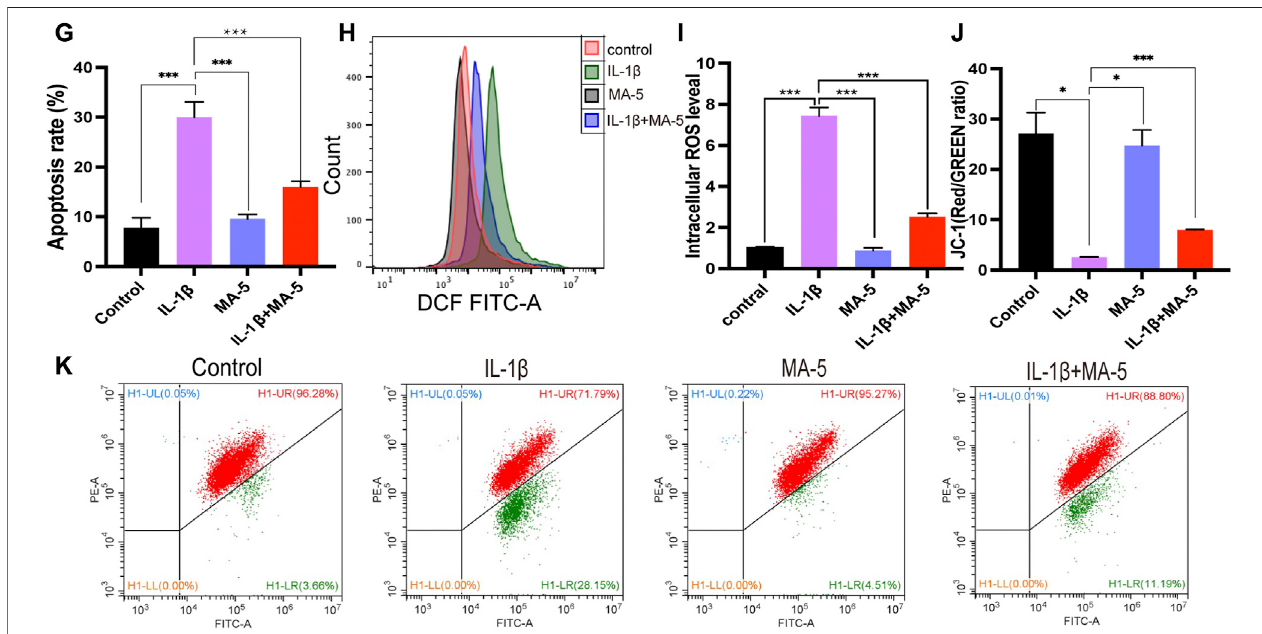
FIGURE4| MA-5promotesSIRT3expressionandactivatesParkin-dependentmitophagy. (A – C) SIRT3andParkinlevelsinOAcellsweredetectedusingwestern blotting. (D) Difference in Parkin fl uorescent signal in mitochondria were assessed using confocal microscopy. (E) Differences in LC3B expression among different treatmentgroupsweredetectedviaimmuno fl uorescence. (F – K) Cellapoptosis, ROS,andmembranepotentialweredetectedvia fl owcytometry. Alldataarepresented as mean ± standard deviation. *** p < 0.001, ** p < 0.01, and * p < 0.05 represent differences between groups, as determined using a one-way analysis of variance.(a),